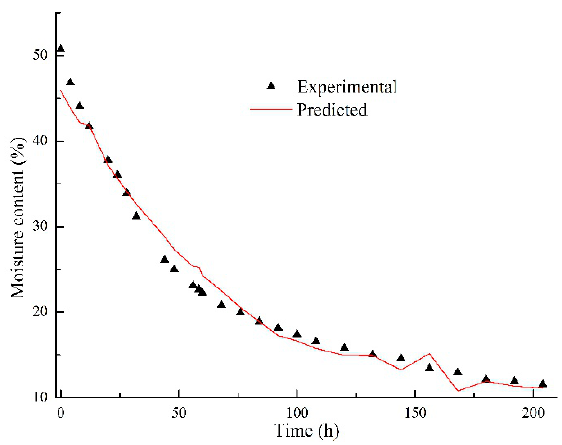
Figure 7. Simulation results of BP neural network.